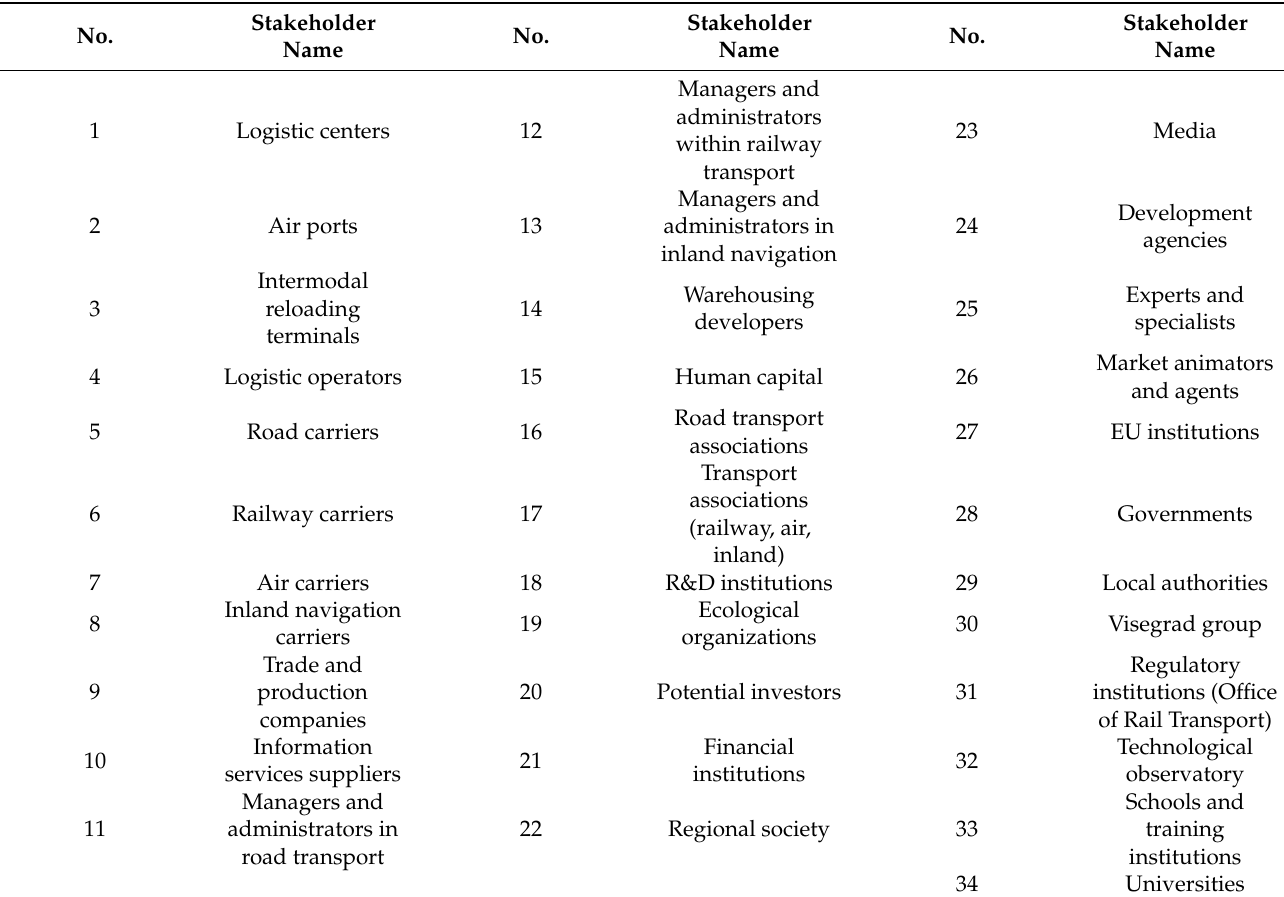
Table 4. List of multimodal transport development stakeholders in the selected cross-border area.